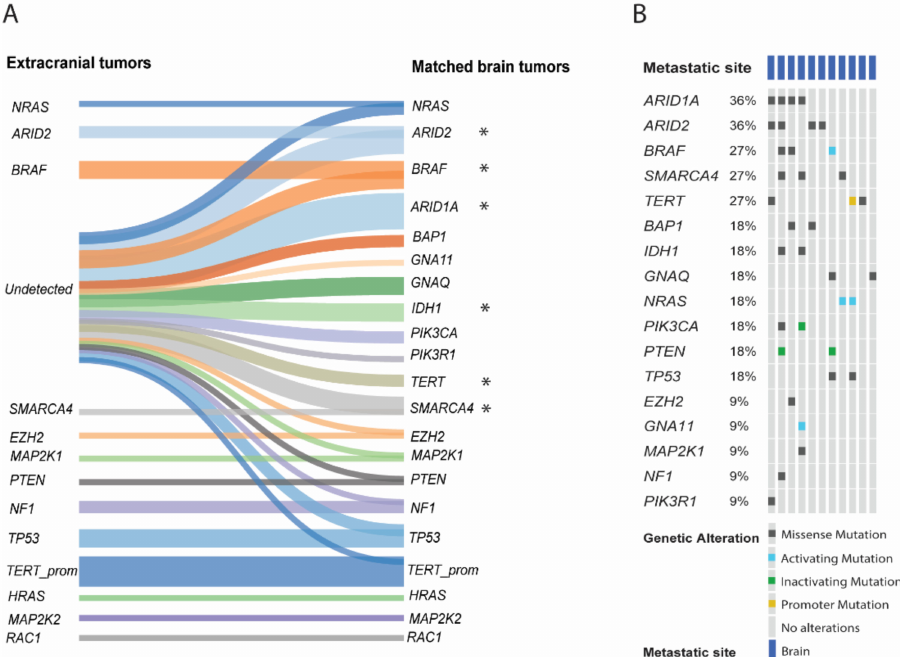
Figure 2. ( A ) Sankey diagram illustrating the shared and unique variants in 20 genes across 11 matched samples (left: extracranial, right: brain tumor tissues). Variants that were detected in extracranial, but not in brain metastases are not shown. Asterisk indicate p ≤ 0.05 significance from Chi-square test, where the proportion of samples with shared and unique variants were tested (extracranial vs. BM vs. both). ( B ) OncoPrint chart displaying the frequency of detectable alterations in 17 genes that were specific to brain